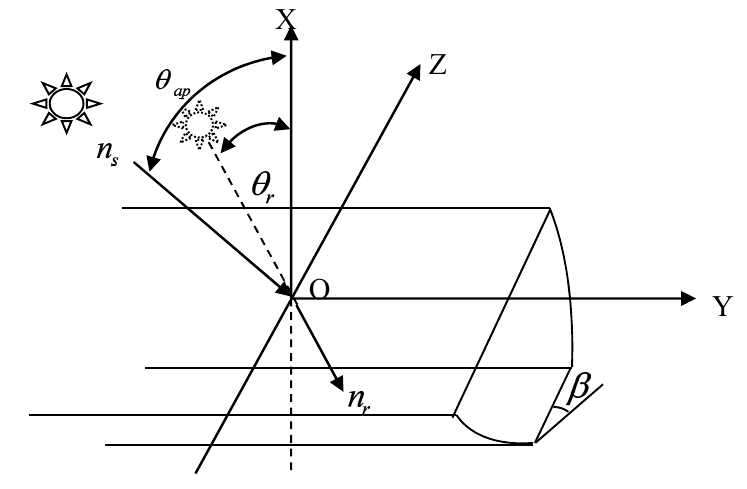
Figure 2. Vectors of incident and refractive Figure 2 . Vectors of incident and refractive rays. Figure 2 . Vectors of incident and refractive rays.